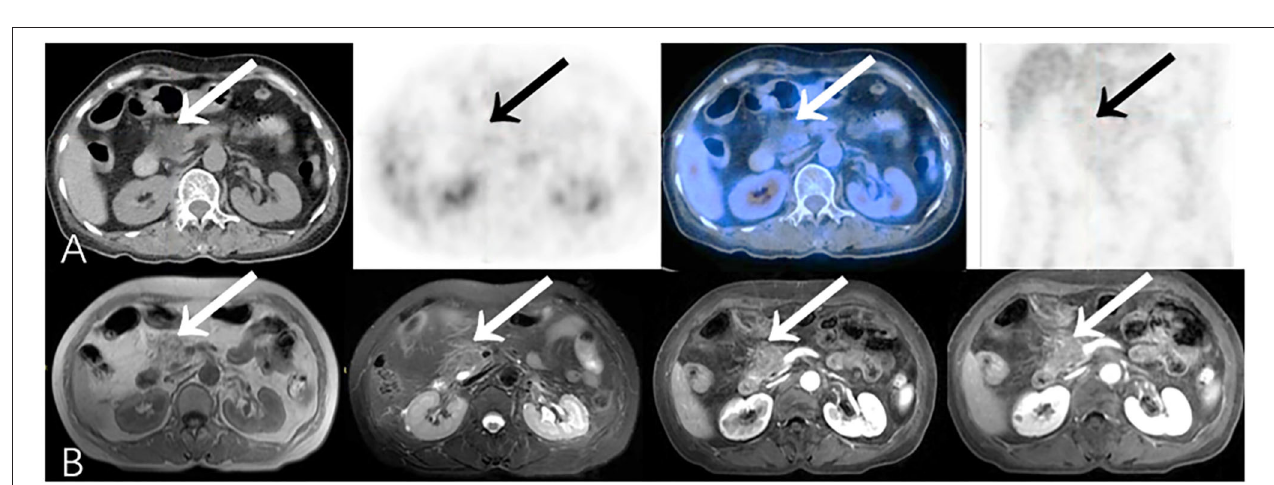
FIGURE 7 | Representative patient on PET/CT (True-Negative) compared to CEMR (False-Positive): A 61-year-old female experienced abdominal pain, nausea and vomiting for 20 days. Serum CA19-9 was normal (12.2 U/ml). (A) PET/CT showed hypodense area without obvious increased focal 18 F-FDG uptake (SUVmax 1.8) in head of pancreas, which was considered as benign lesion. (B) Lesion was inhomogeneously mildly enhanced on CEMR imaging, presumed more likely to be malignancy. Patient refused to undergo biopsy, and improved after symptomatic treatments. During long-term clinical follow-up ( > 16 months), patient had no complaints of special